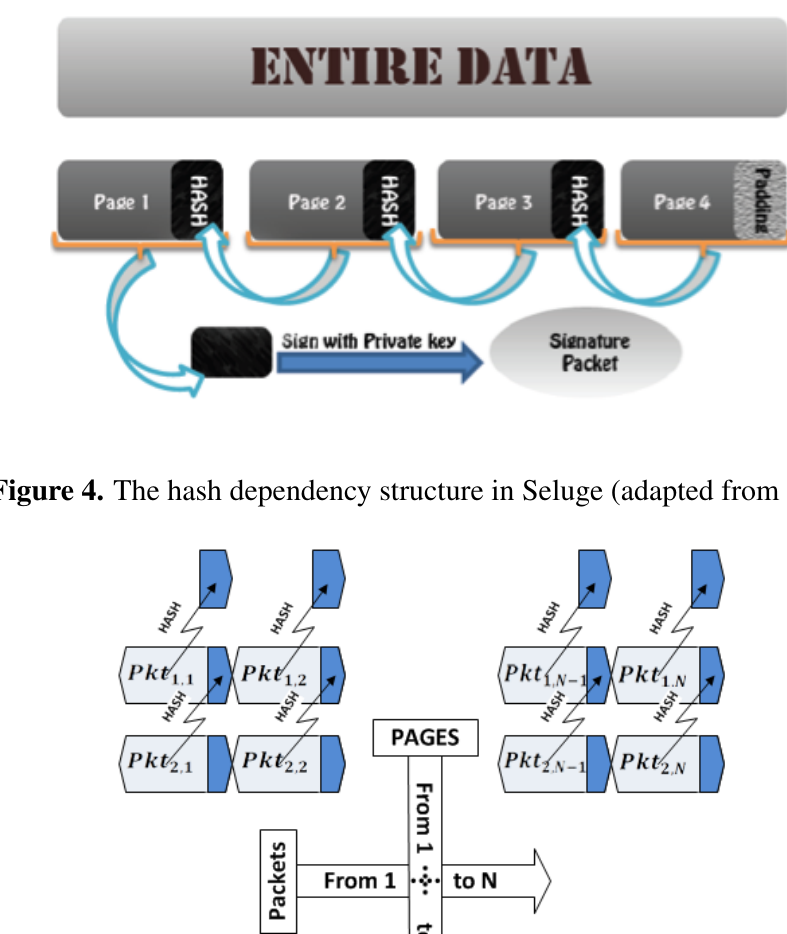
Figure 3. Integrity verification using hash dependency.